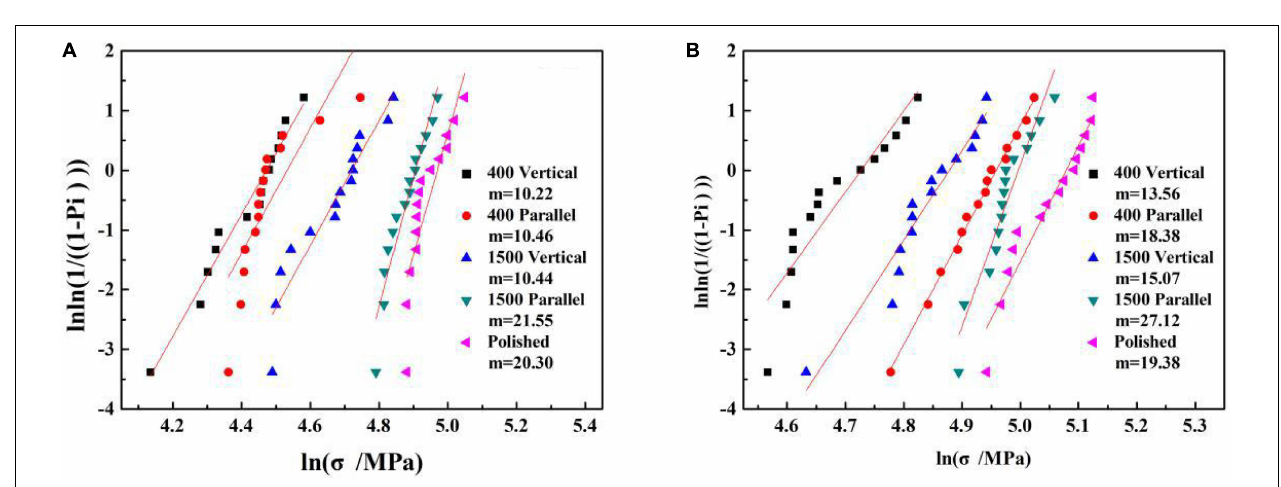
FIGURE 6 | Weibull plots of flexural strength of PICN BTC in panel (A) and PICN UTC in panel (B)